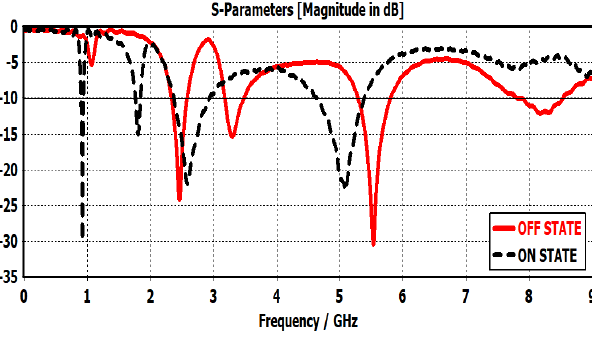
FIGURE 3. Simulated coefficient of the single antenna at different states